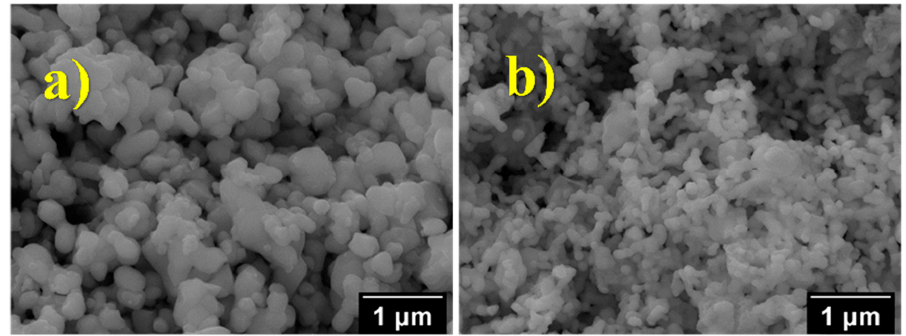
Figure 5. SEM images of SNTO ( a ) and SNWO ( b ).